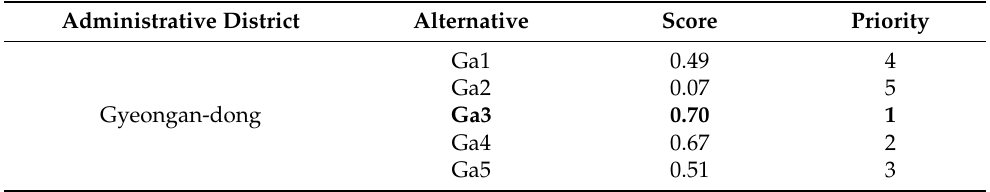
Table 7. Selection of optimal shelters by administrative district; the first priority shelter in each area is expressed in